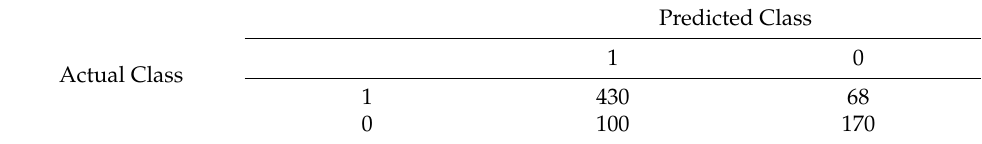
Table 6. Confusion matrix of CNN.